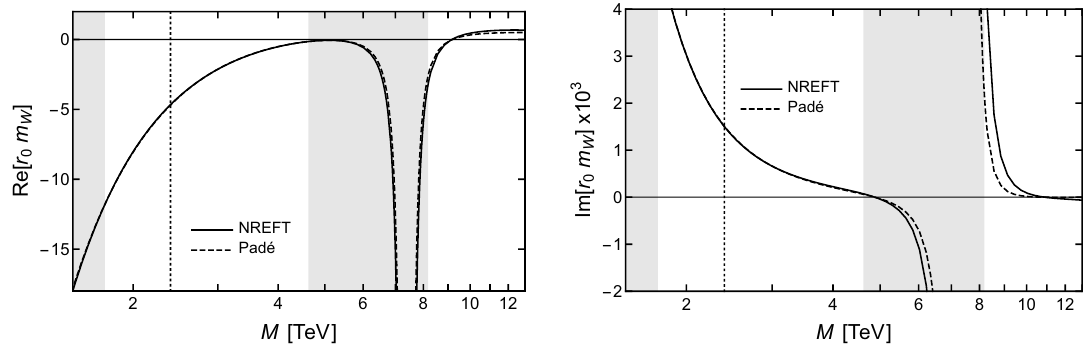
Figure 10 . Real and imaginary parts (left and right panels) of the neutral-wino e(cid:11)ective range r 0 as functions of the wino mass M (solid curve). In the left and right panels, the dashed curves are the Pad(cid:19)e approximants in eqs. (3.17a) and (3.17b), respectively. The vertical dotted line indicates the unitarity mass M (cid:3) = 2 : 39 TeV. The grey regions are the ranges of M in which j (cid:13) 0 j > m W , so a ZREFT for neutral and charged winos is not